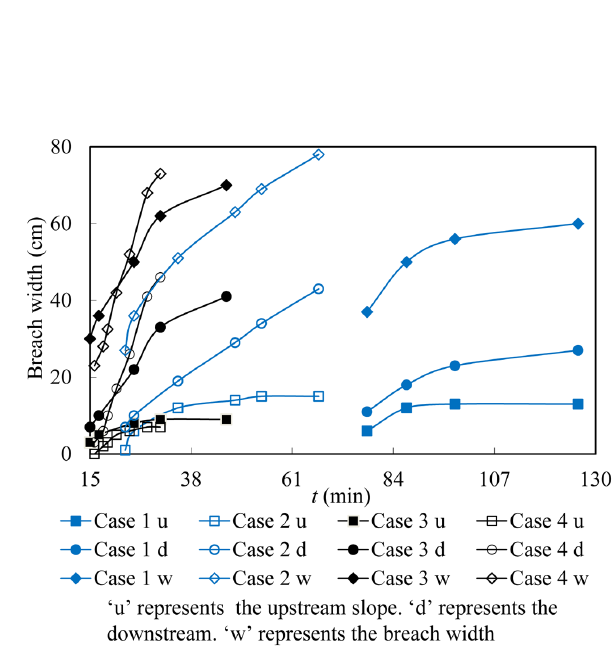
Figure 7. Breach widening